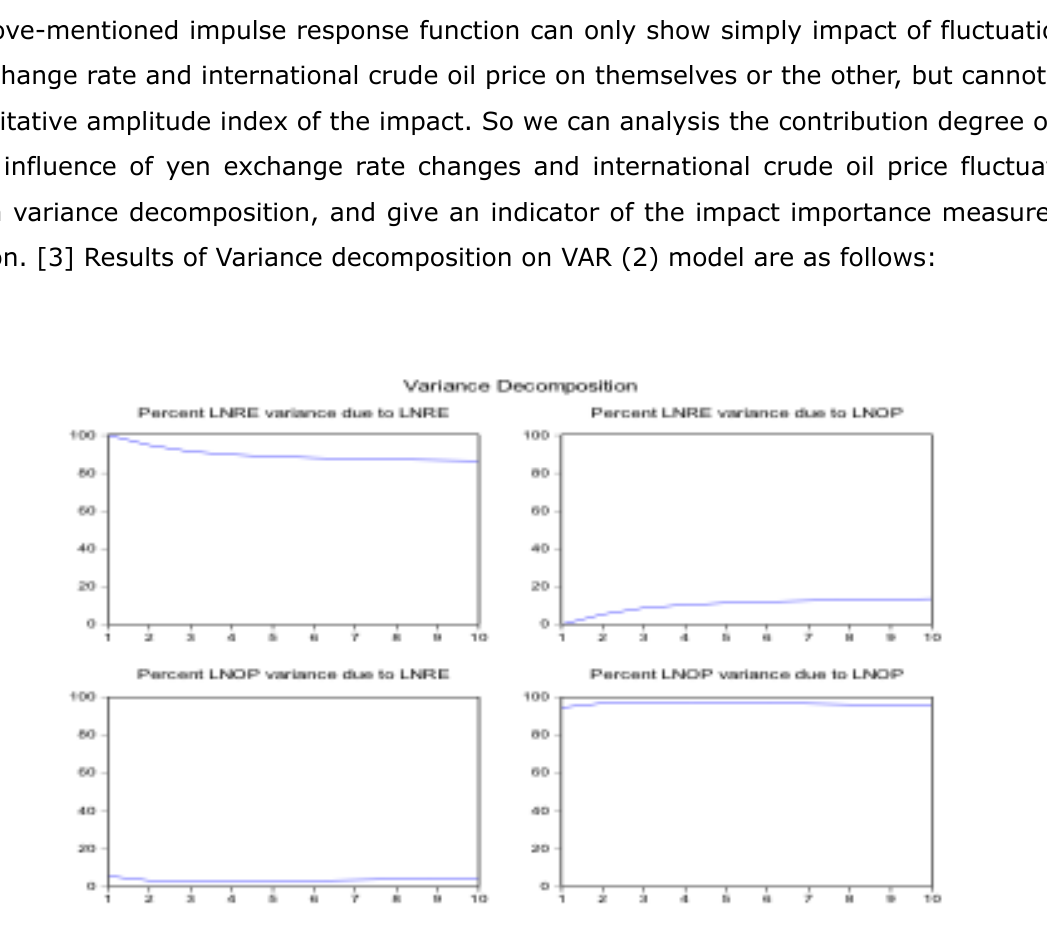
Figure 4. Schematic diagram of variance decomposition of yen exchange rate changes and